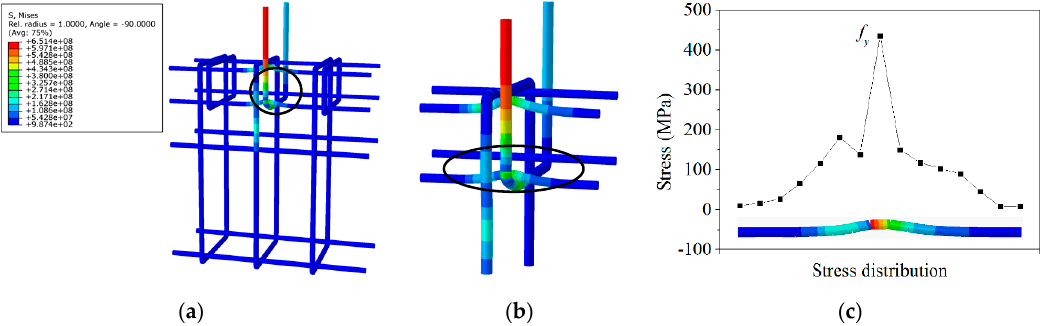
Figure 10. Stress analysis of the down horizontal rebar in the specimen. ( a ) Yielding of the horizontal rebar; ( b ) Partial display; ( c ) Stress distribution.